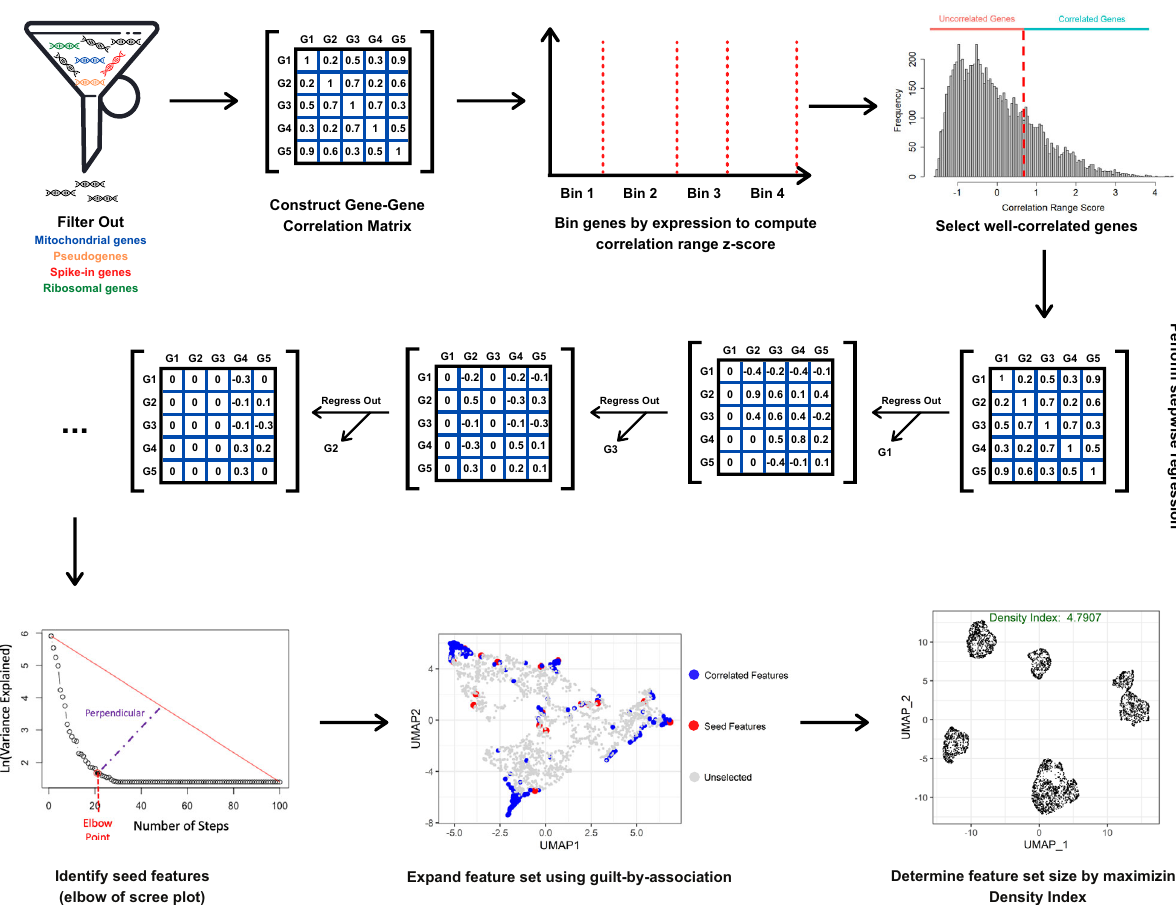
Fig. 1 Overview of DUBStepR work fl ow. After fi ltering out mitochondrial, ribosomal, spike-in, and pseudogenes, DUBStepR constructs a GGC matrix and bins genes by expression to compute their correlation range z-scores, which are used to select well-correlated genes. DUBStepR then performs stepwise regression on the GGC matrix to identify a minimally redundant subset of seed features, which are then expanded by adding correlated features (guilt-by-association). The optimal feature set size is determined using the Density Index